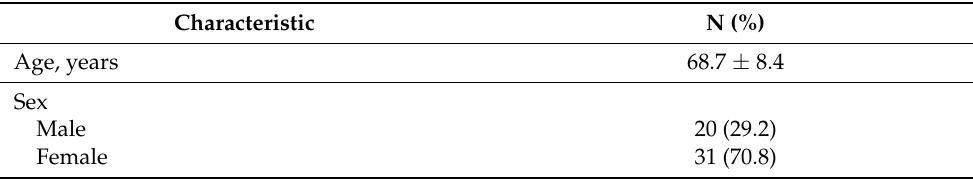
Table 1. Clinical characteristics of patients in the